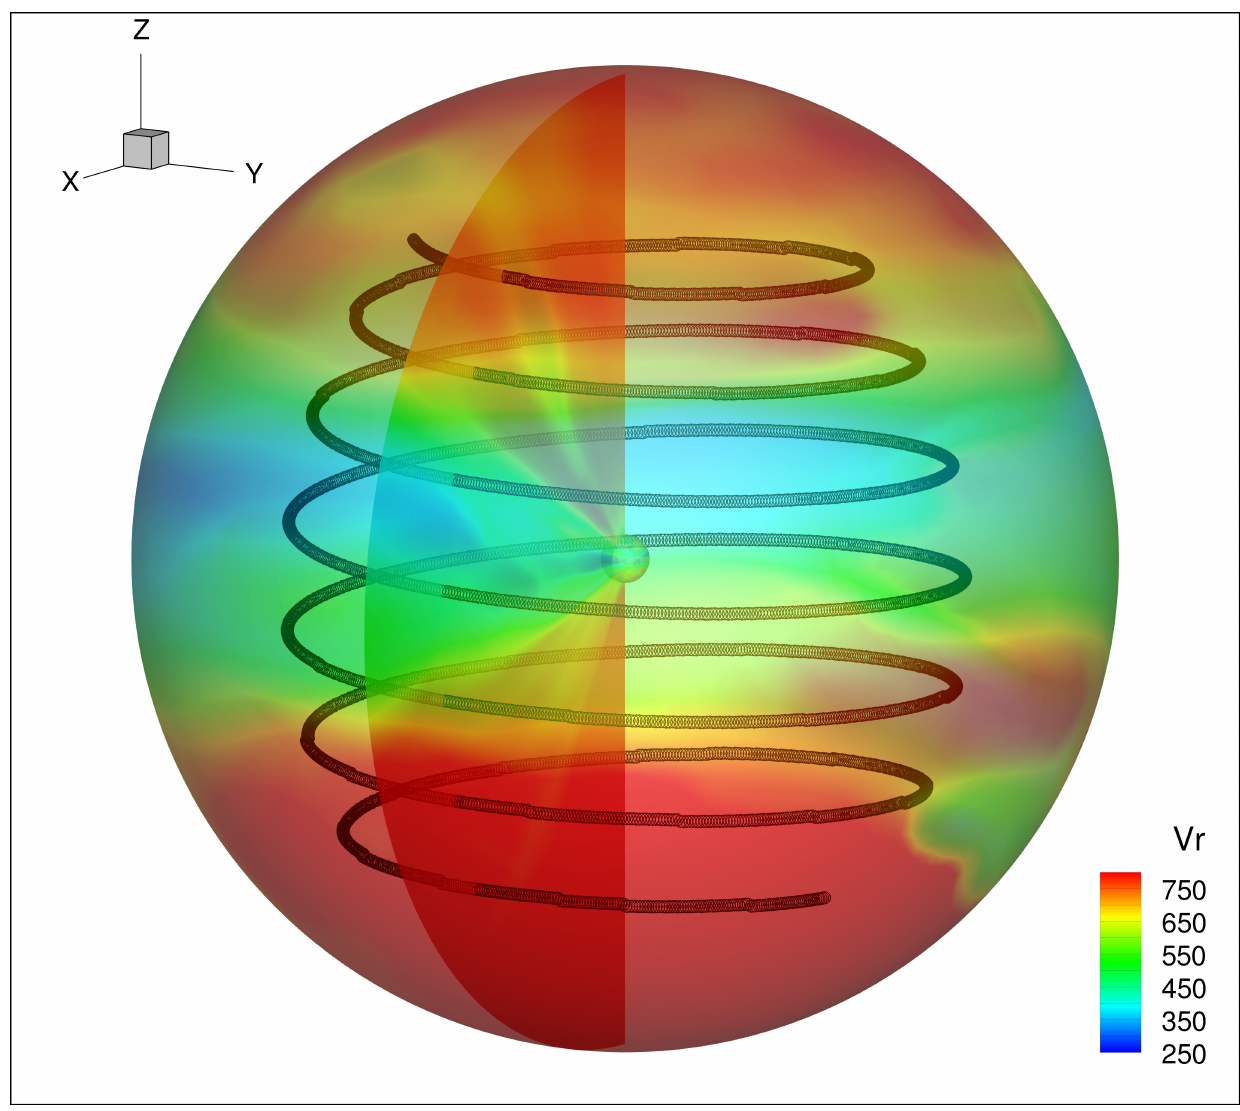
Figure 7. The schematic diagram for the Ulysses trajectory in the Carrington coordinate system during CR2057 to CR2062. The trajectory is shown as the black